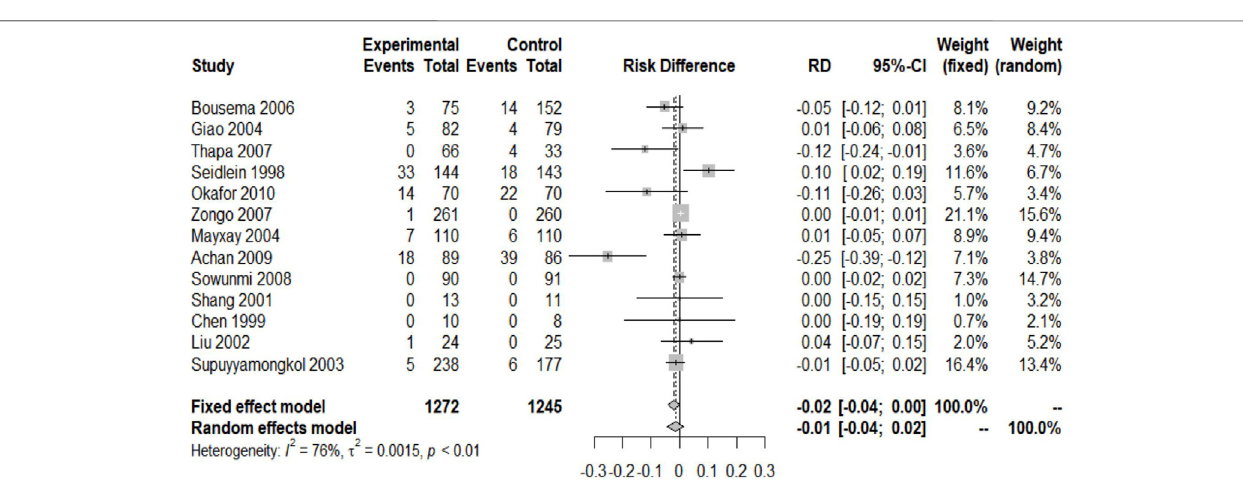
Frontiers in Pharmacology |